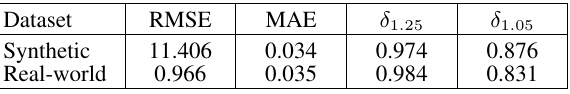
Table 3. Results of our depth estimation on both datasets.